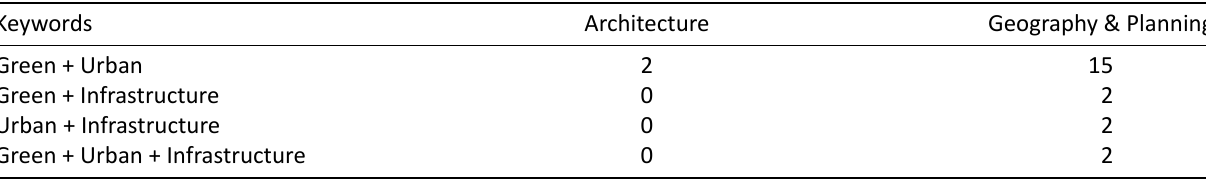
Table 2. 2017 Module catalogue key word search results at Cardiff